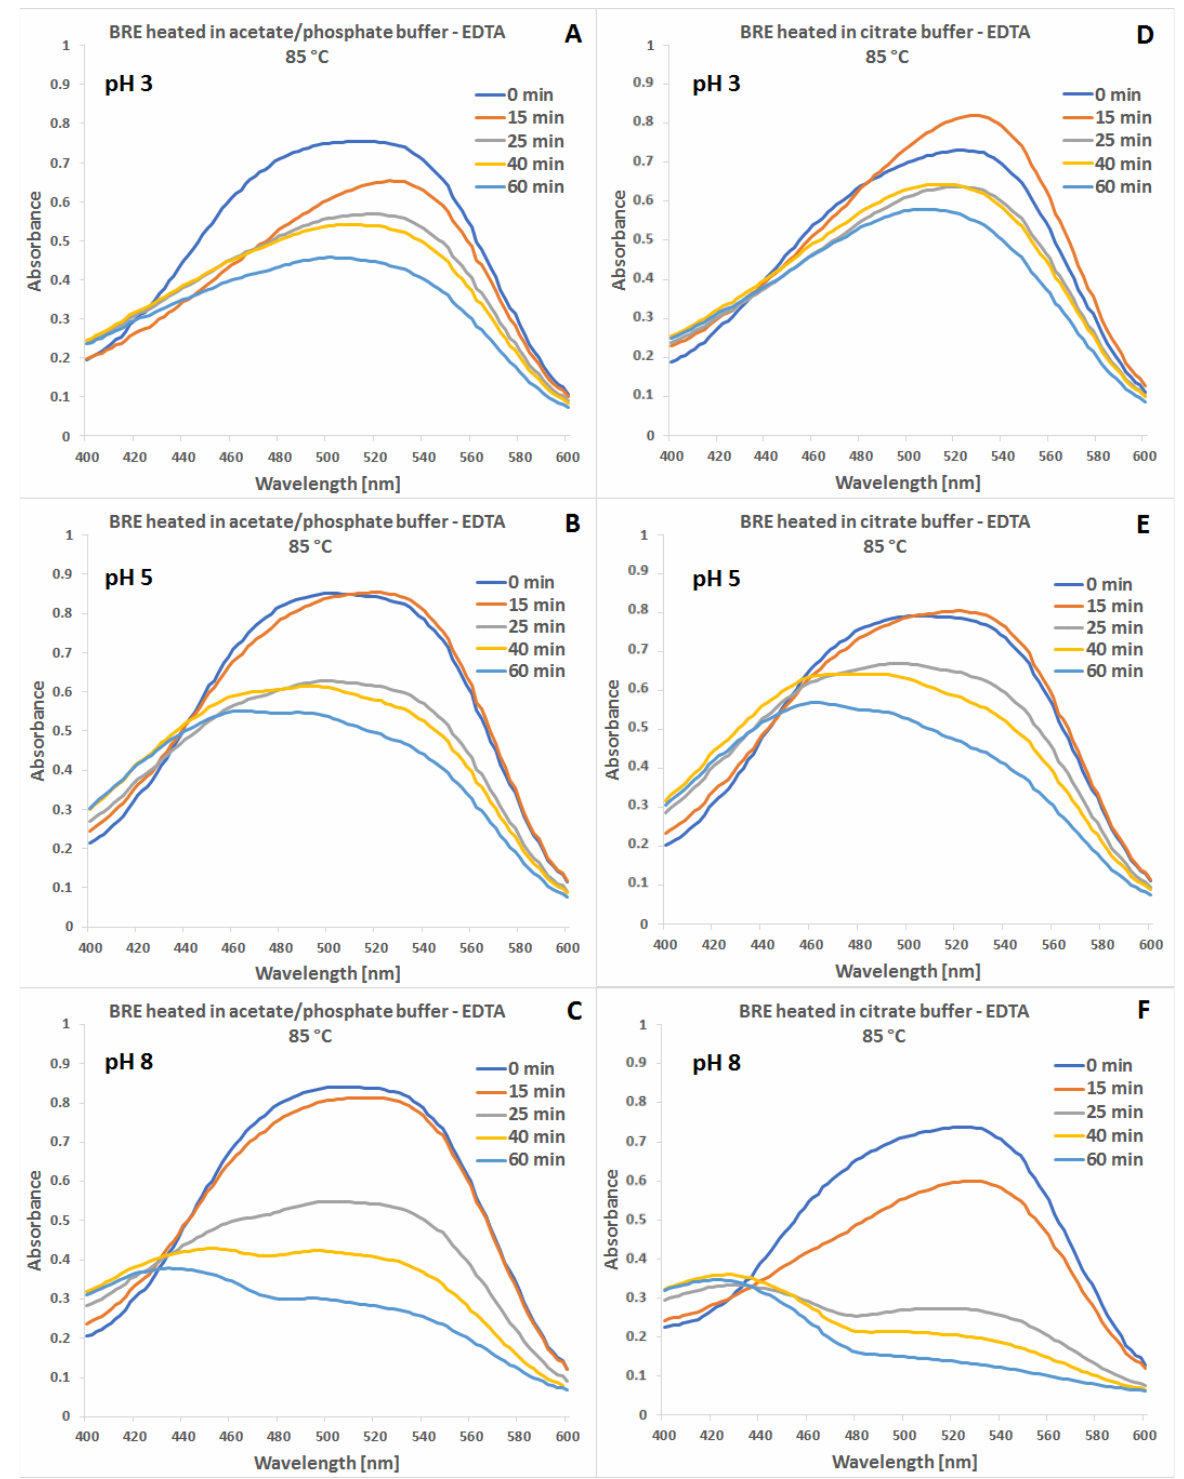
Figure 3. Visible spectra of betalain-rich extract (BRE) samples containing EDTA collected during their heat processing at 85 ◦ C in acetate/phosphate ( A – C ) and citrate buffers ( D – F ) at pH 3, 5 and